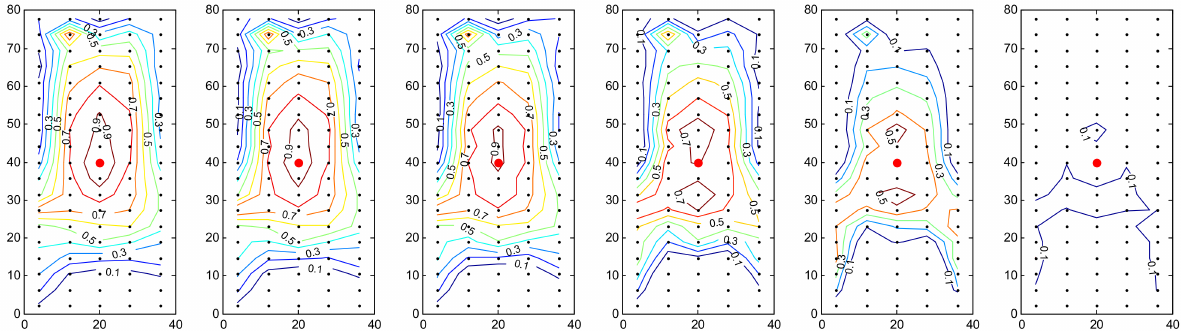
Figure 4. Lower rectangular model with higher curvature (RLC). Level curves of the correlation function between the pressure–time history in the center of the roof (pressure tap #48) and the other points of the roof surface, for different delay times τ between the reference point and the other points. From left to right: τ = 0 s, τ = 0.004 s, τ = 0.008 s, τ = 0.02 s, τ = 0.04 s, τ = 0.08 s. Color bar as in Figure